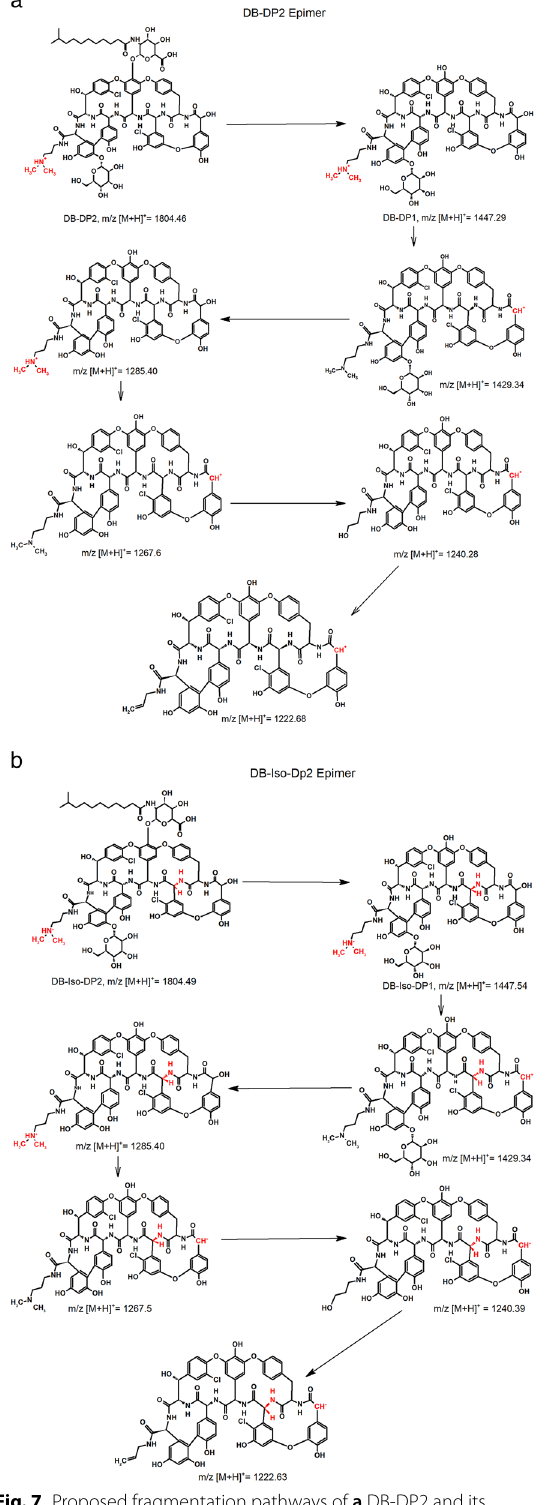
Fig. 7 Proposed fragmentation pathways of a DB-DP2 and its diastereomer b DB-Iso-DP2 showing the analogous pathways for the two